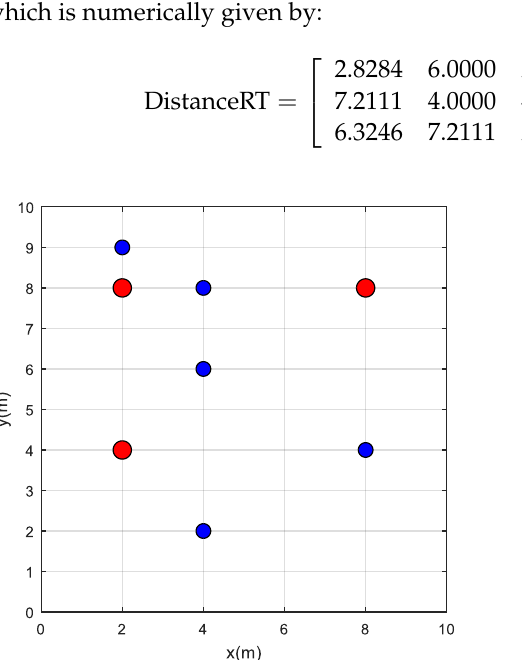
Figure 2. Plot of reference and target nodes for case